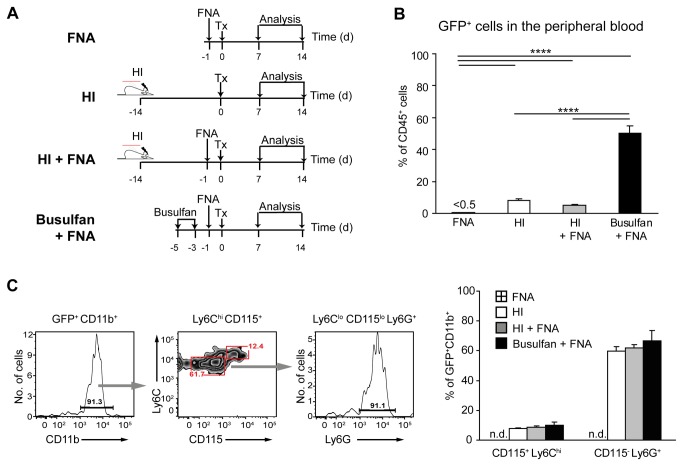
Blood chimerism in HI- and busulfan-conditioned mice with FNA.
A) Overview of the experimental protocol. HI, FNA and Tx denote focal head irradiation, facial nerve axotomy and bone marrow transplantation, respectively. B) Flow cytometry of GFP expression in peripheral blood CD45+ cells at 2 weeks after BMT. The level of chimerism was significantly higher in the busulfan + FNA group compared with the HI + FNA group. FNA had no impact on blood chimerism. Data are means + SEM from 3-5 animals per group. Statistical significance is indicated by asterisks (****p<0.0001). C) Flow cytometric characterization of GFP-expressing cells in peripheral blood at 2 weeks after BMT. The vast majority of GFP+CD45+ cells express CD11b (>90%). Gating of this cell population reveals predominantly CD115+Ly6ChiLy6G- monocytes and CD115-Ly6C+Ly6G+ neutrophils. Data are means + SEM from 3-5 animals per group. n.d. = none detected. No statistical differences were observed between the groups.